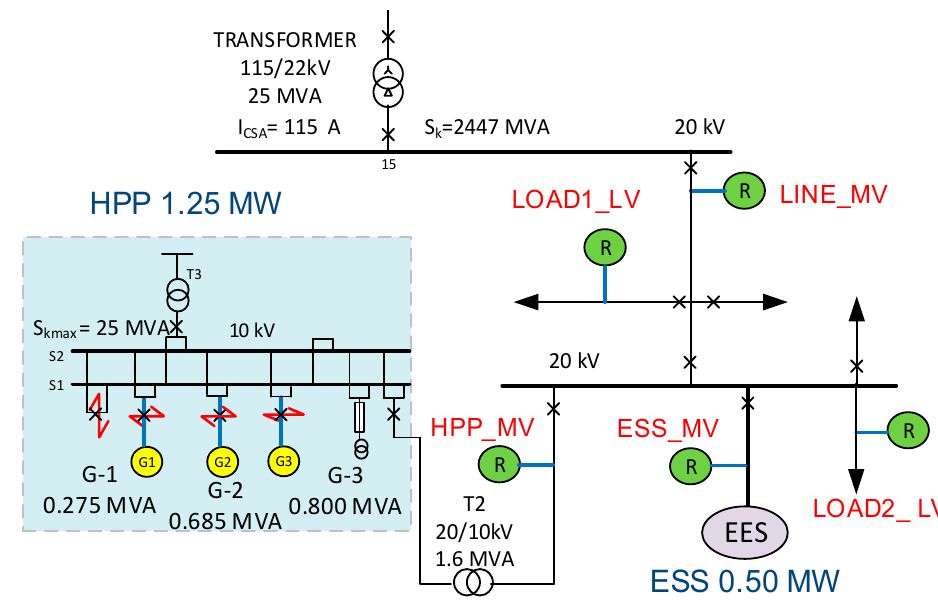
Figure 2. The virtual power plant with the power quality (PQ) recorders placements. Where: LINE_MV: medium voltage line that connects the virtual power plant (VPP) to 110/20 substation; HPP_MW: 1.25 MW hydropower plant; ESS_MW: 0.5 MW electric energy storage; LOAD1_LV: low voltage load related with LINE_MV; LOAD2_LV: low voltage load related with the hydropower plant (HPP) and ESS substation.